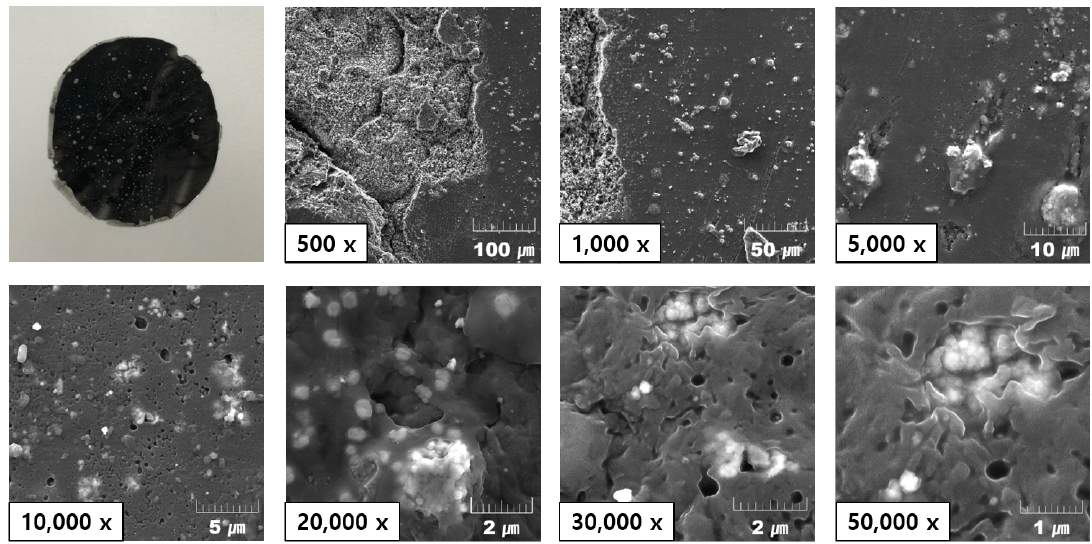
Figure 5. Scanning electron microscopy (SEM) image of the as-fabricated PA6/Fe 3 O 4 (75 wt%) susceptor.